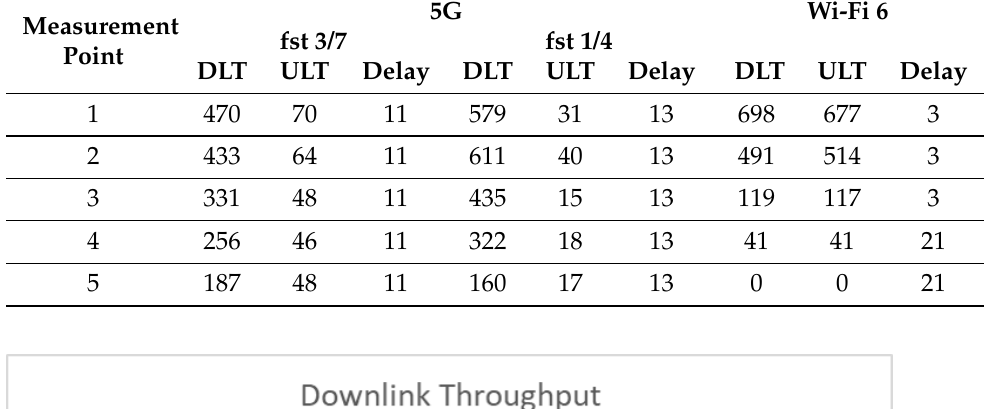
Table 3. Measured peak throughputs (Mbps) and average delay (ms) for Wi-Fi 6 and 5G (DLT/ULT = downlink/uplink throughput).